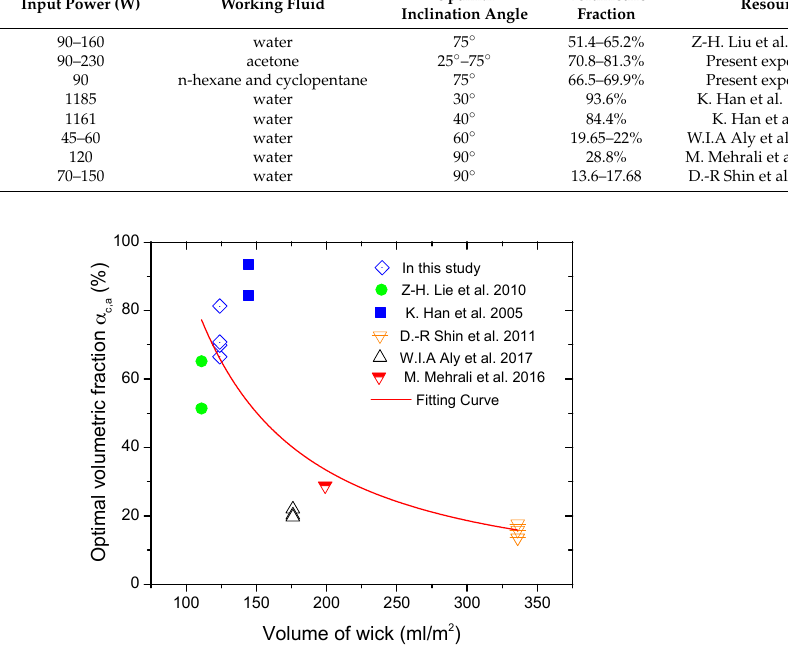
Table 5. The optimal volumetric fraction of specific groove heat pipes from the literature. Volume of Wick (mL/m 2 )